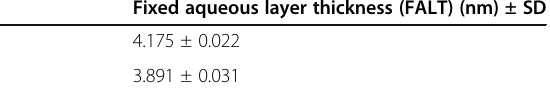
Table 12 Results of fixed aqueous layer thickness (FALT) Product